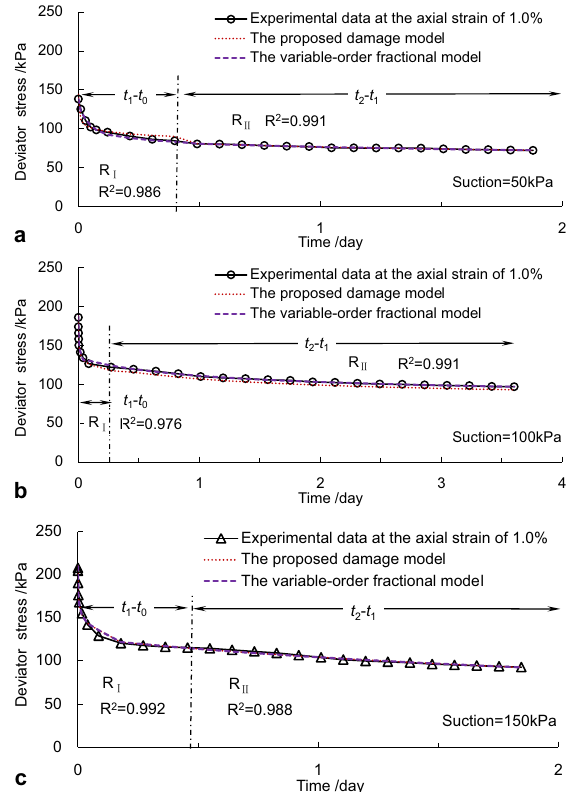
Figure 7. Comparison of simulated curves with measured curves: ( a) case A, ( b) case B, and ( c) case